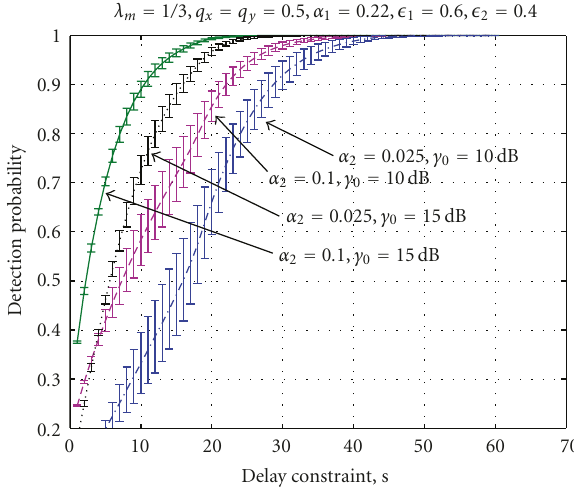
Figure 8: Deviation of the detection performance due to unavail- ability of the exact target location: T s = 1s, v = 1m/s, γ 0 = 10 dB,